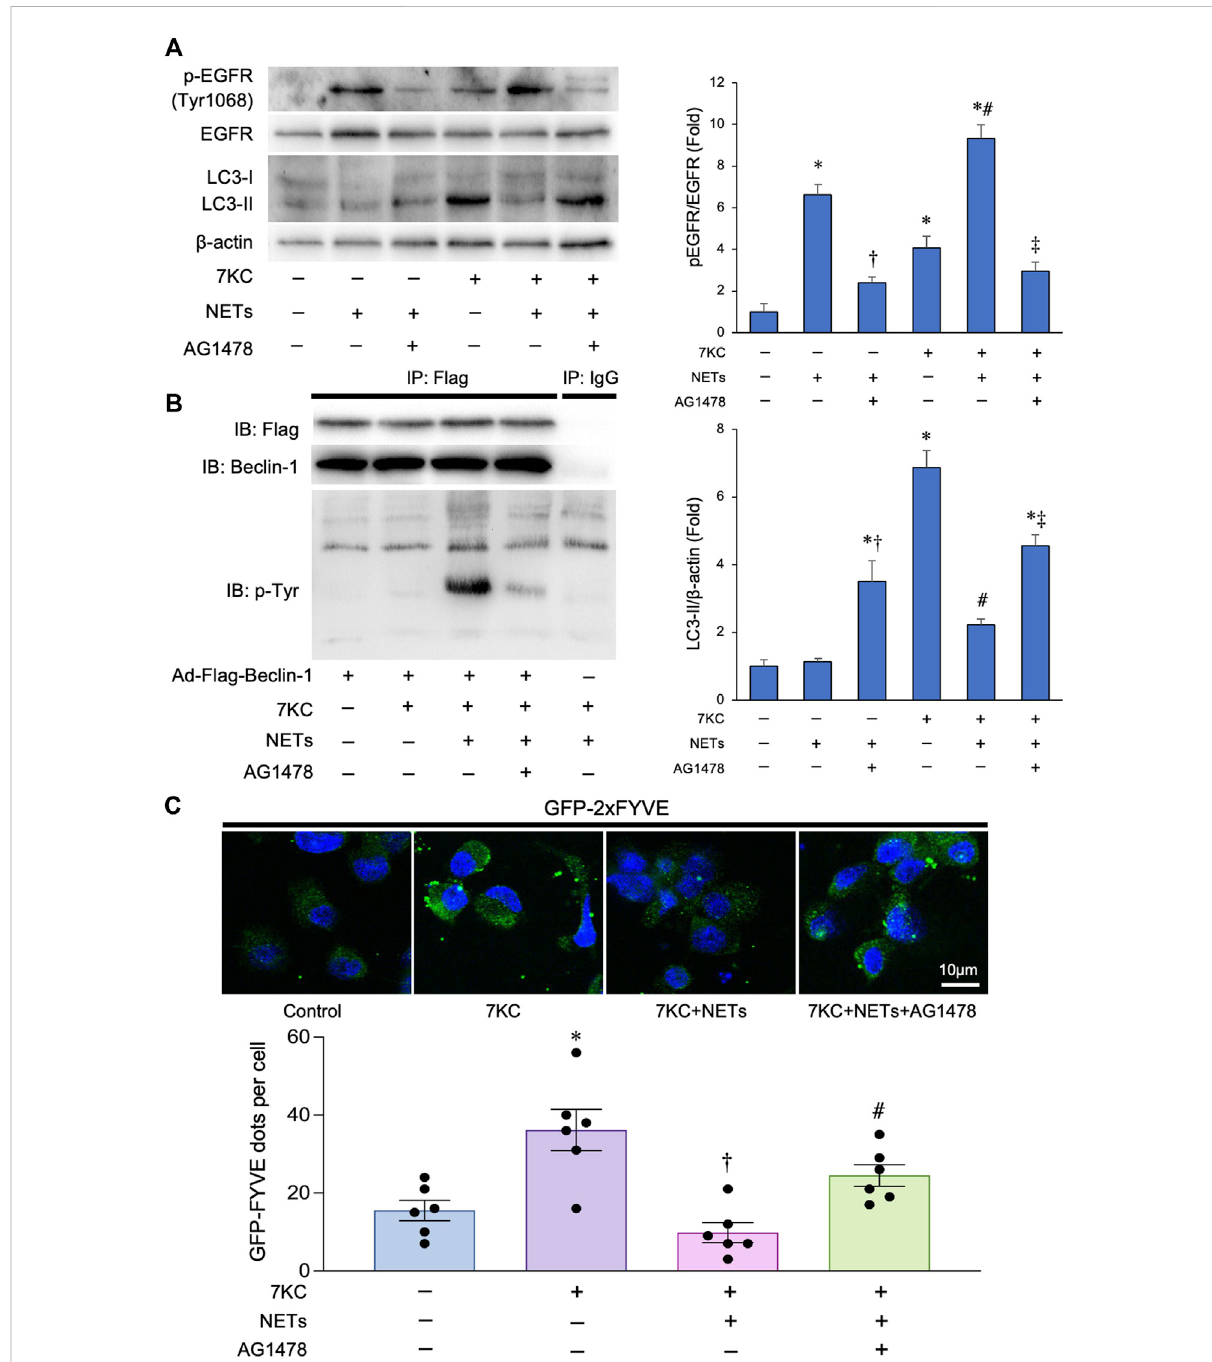
FIGURE 4 Effects of NETs for Beclin 1 phosphorylation and Beclin 1-associated PI3-K activation in macrophages. (A) Left panel: Representative immunoblotimagesofLC3,EGFR, phospho-EGFR(Tyr1068),and β -actin.Rightpanels:Densitometricanalysisofimmunoblots.* p < 0.05vs.control group, † p < 0.05 vs. NET-treated group, # p < 0.05 vs. 7KC-treated group, ‡ p < 0.05 vs. 7KC + NET-treated group, n = 3 in each group. All data are expressedasmean±SEM. (B) MacrophagesderivedfromtheTHP-1cellsweretreatedwitha7KCafterAd-Flag-Beclin-1transductionandthen treated with or without the NETs or AG1478, a potent EGFR tyrosine kinase inhibitor. 48 h after the transduction, lysates were extracted for co- immunoprecipitation with phospho-Tyrosine-speci fi c antibody or control IgG, followed by probing with Beclin-1 antibody. Representative images areshown. (C) Membrane-associatedphosphoinositide3-kinase(PI3-K)assay in-situ .MacrophagesderivedfromtheTHP-1cellsweretreatedwitha 7KC after Ad-GFP-2×FYVE transduction, and then treated with or without NETs or AG1478. Upper: Representative images of GFP-2×FYVE dots are shown. Lower : Quantitative analysis of the number of GFP-2×FYVE dots is shown. * p < 0.05 vs. control group (Blue bar), † p < 0.05 vs. 7KC-treated group(Purplebar), # p < 0.05vs.7KC+ NETs-treatedgroup(Pinkbar), n =6ineachgroup. Dataareexpressedasthedotplotsandbars,withthelines indicating the mean ±